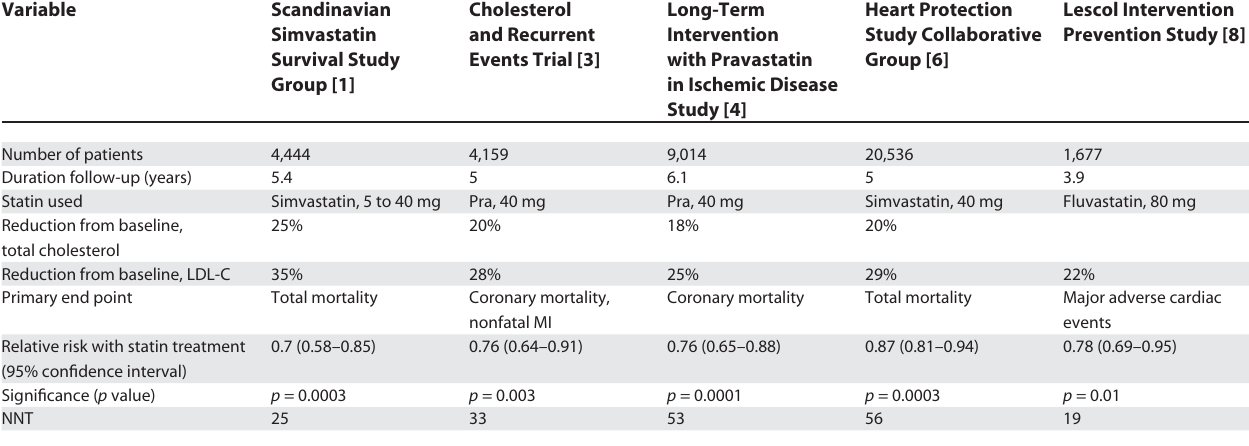
Table 1. Placebo-Controlled Secondary Prevention Statin